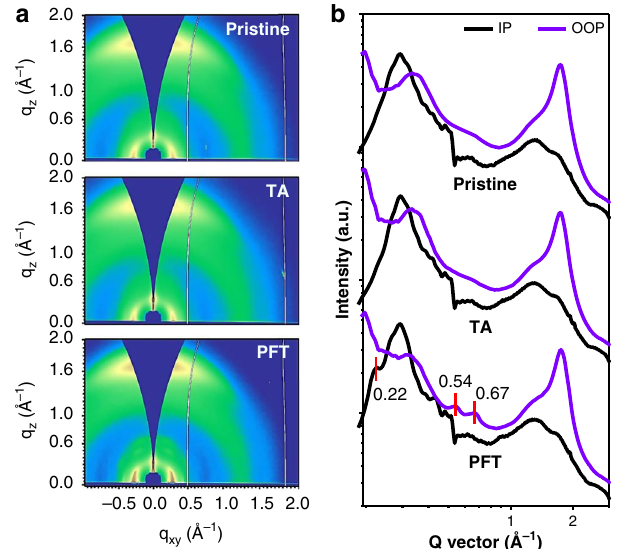
Fig. 2d. Combining the observation from GIWAXS and micro- scopies, it is clear the molecular reorganization induced by PFT treatment can enhance crystallinity of both PM6 and Y6, leading to improved phase separation in blend fi lms.